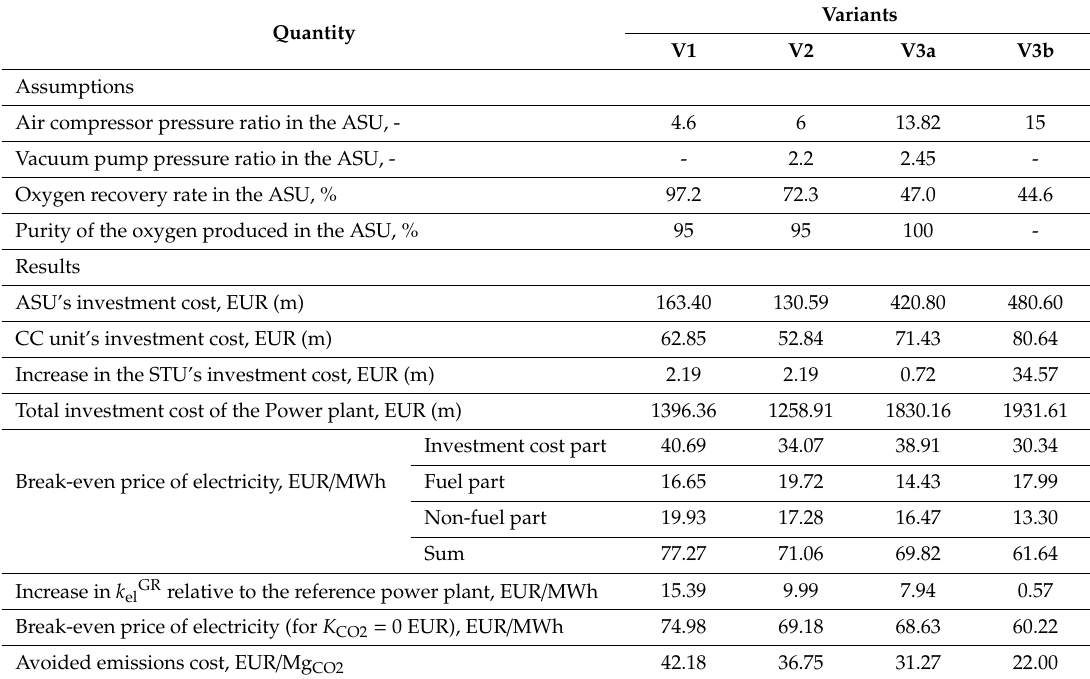
Table 10. Economic analysis